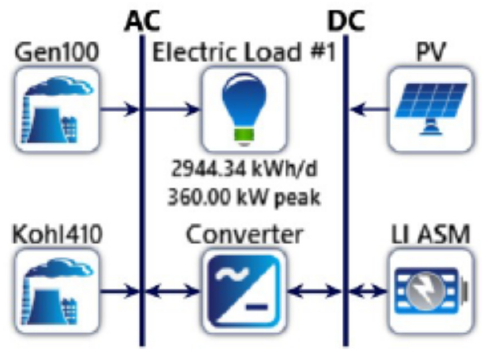
Figure 5. Scheme of the hybrid system without BESS (Battery Energy Storage System) solution.